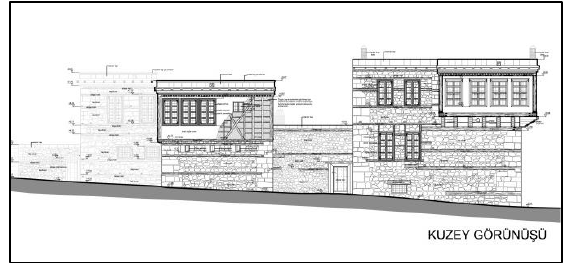
Figure 19. Northern View (Restoration Project)